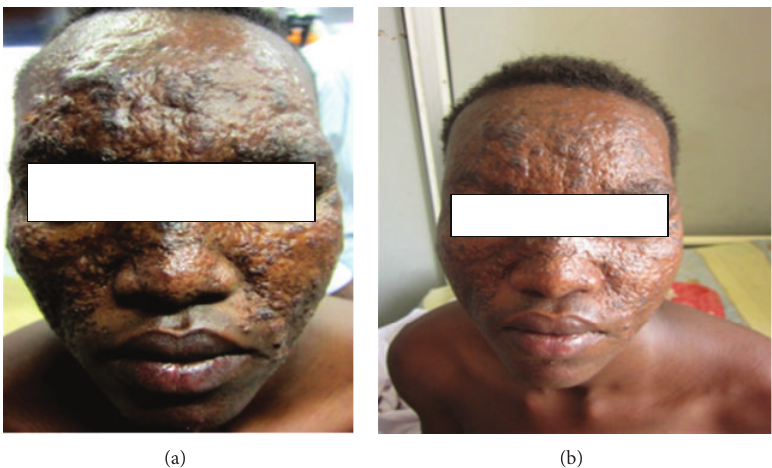
Figure 7: (b) is patient no. 1 before treatment. (a) is the patient just 10 days after treatment with Pentostam. Lesions started to regress and finally healed completely.